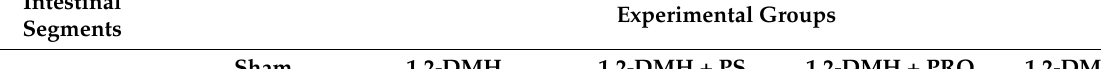
Table 2. Histopathological score of inflammation in the three colonic segments. The scores are expressed as the median, minimum, and maximum values, where # p < 0.05 vs. Sham and * p < 0.05, ** p < 0.01 vs. 1,2-DMH group. The data were analyzed using the Kruskal–Wallis test followed by the Dunn’s post-test.